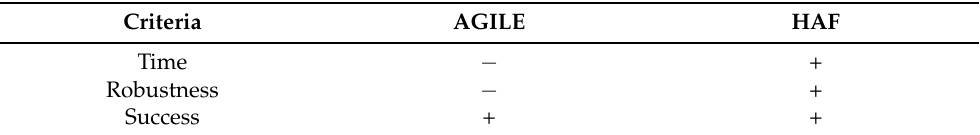
Table 2. Comparing AGILE and HAF.